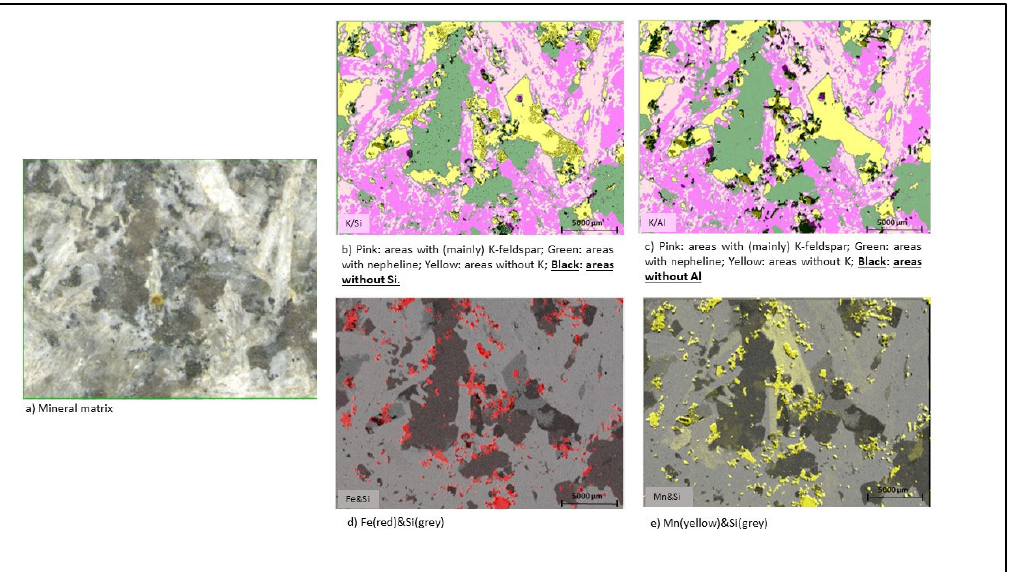
Figure 8. ( a ) Image of original minera sample (mineral matrix). Interpretative maps with evidence of ( b ) areas without Si and without K or ( c ) areas without Al and without K. Distributions of ( d ) Fe, and ( e ) Mn relative to Si.